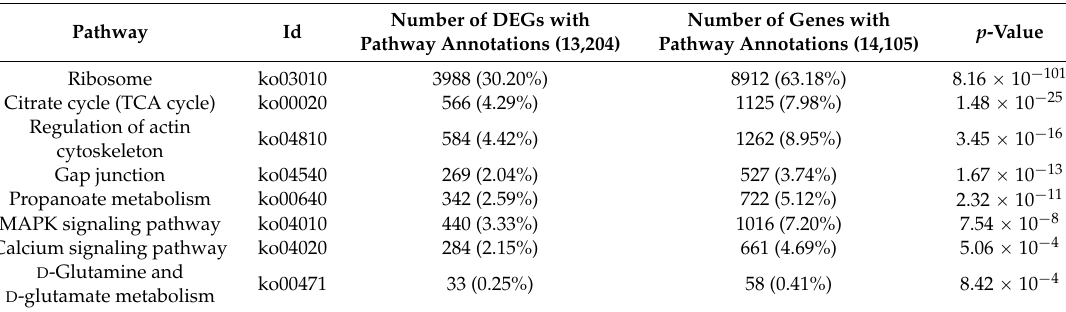
Table 4. Enriched pathways containing down-regulated genes under Pb